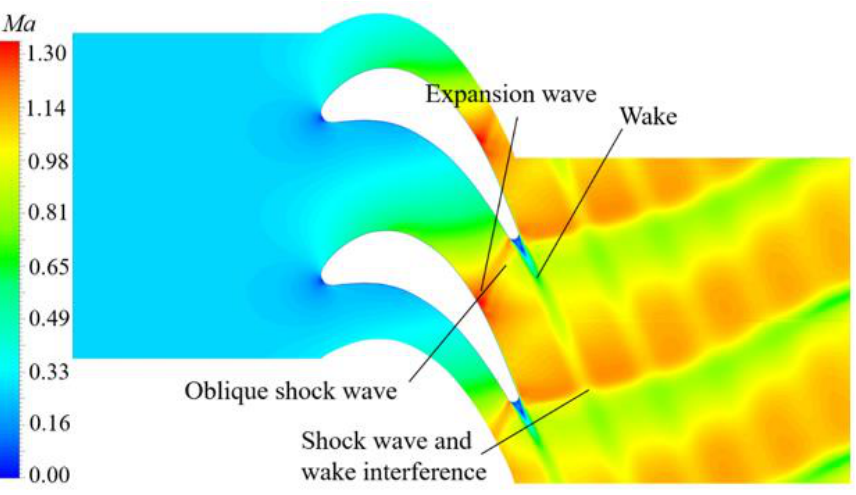
Figure 13. Mach number distribution of flow field.